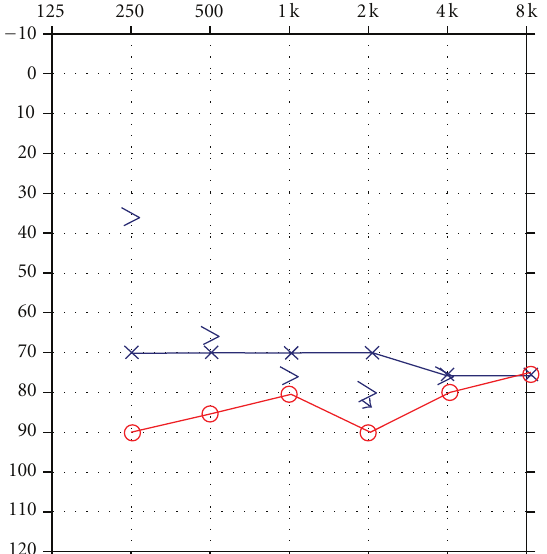
Figure 3: Audiogram depicting the presence of a severe hearing loss for pure tones for both ears.